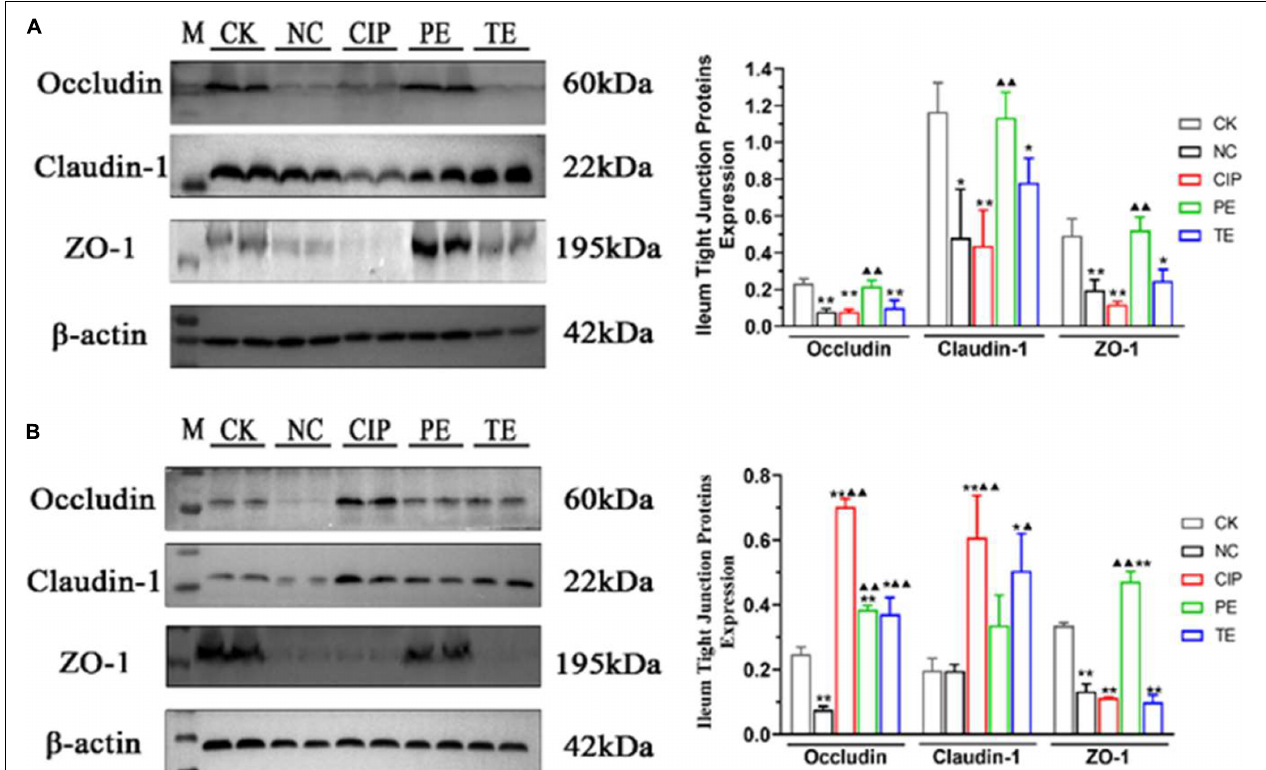
FIGURE 6 | Protein expression levels of occludin, claudin-1, ZO-1 on days 8 (A) and 15 (B) . “M” representative Protein Marker; *Compared with CK group. * P < 0.05; ** P < 0.01; (cid:78) Compared with NC group. (cid:78) P < 0.05; (cid:78)(cid:78) P < 0.01 as determined by Student’s t